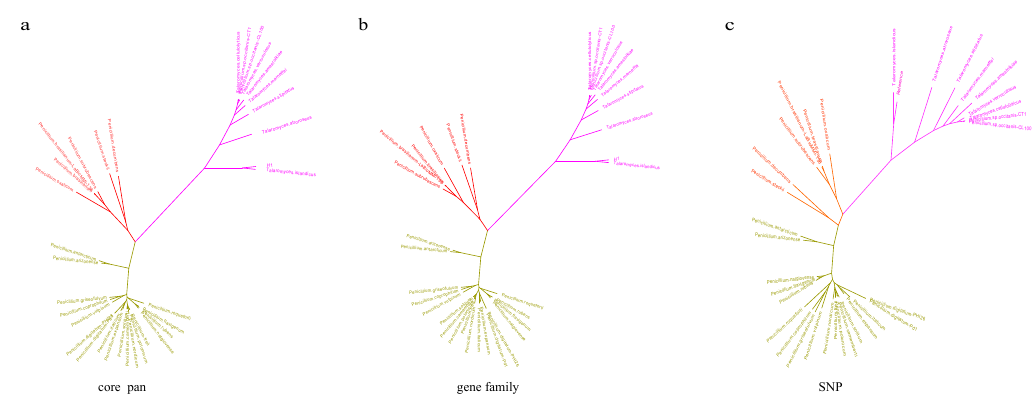
Figure 4. The species phylogenetic trees of Penicillium variabile HXQ-H-1 and other 33 Penicillium genomes. Trees were reconstructed based on core genes ( a ), homolog genes ( b ) and SNPs ( c ) respectively. The three clades are marked with di ff erent colors.